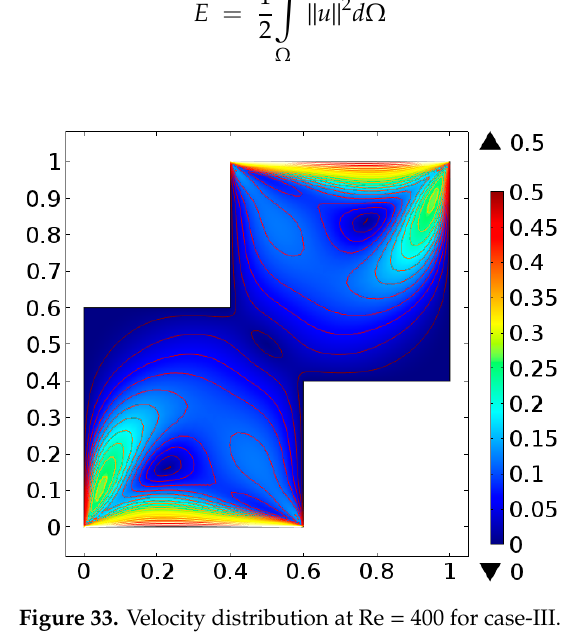
Figure 33. Velocity distribution at Re = 400 for case-III.